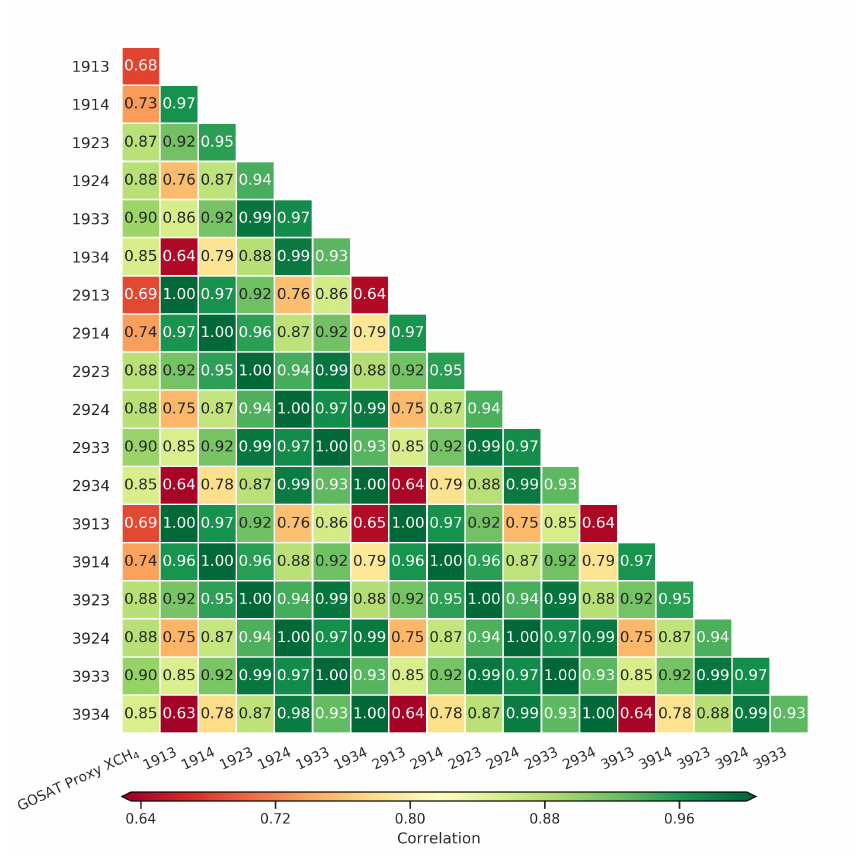
Figure 2. Global correlation coefficient between the wetland CH 4 seasonal cycle derived from the GOSAT Proxy XCH 4 and each WetCHARTs ensemble member (leftmost column) and also between individual ensemble